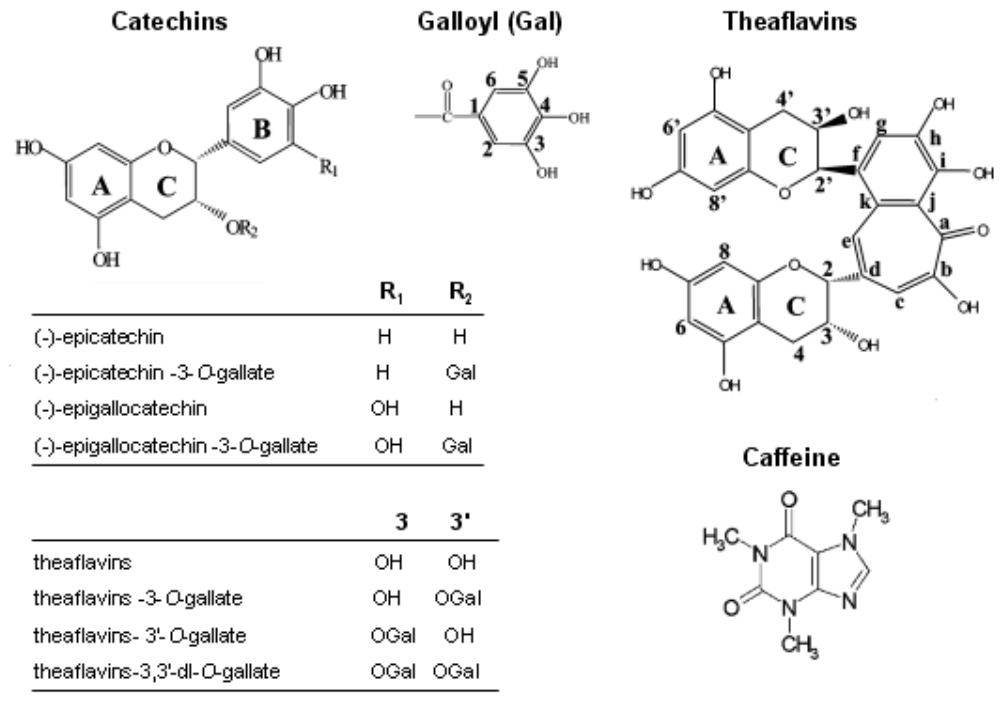
Figure 1. Chemical structures of the investigated compounds in tea